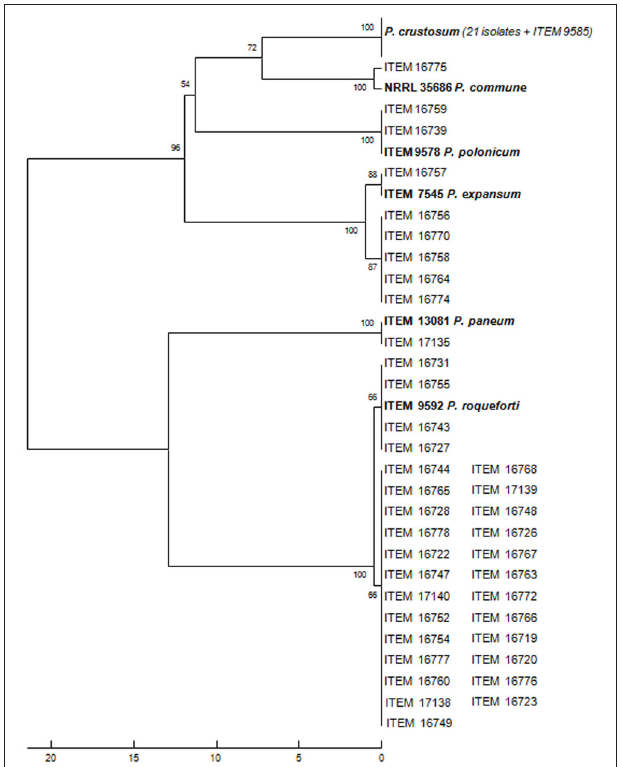
FIGURE 1 | Evolutionary relationships of 60 isolates from olives and 6 species reference